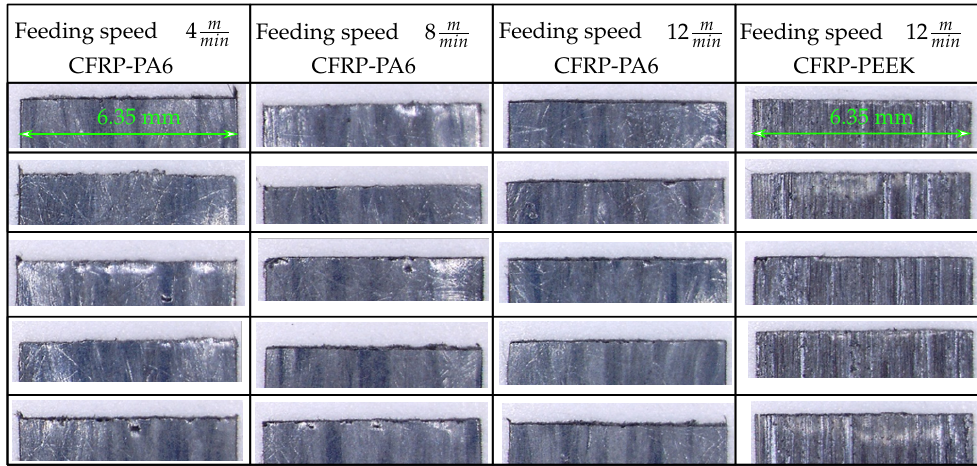
Figure 8. Prototype model for an Adaptive Feeding Roller with an Integrated Cutting System for AFP.